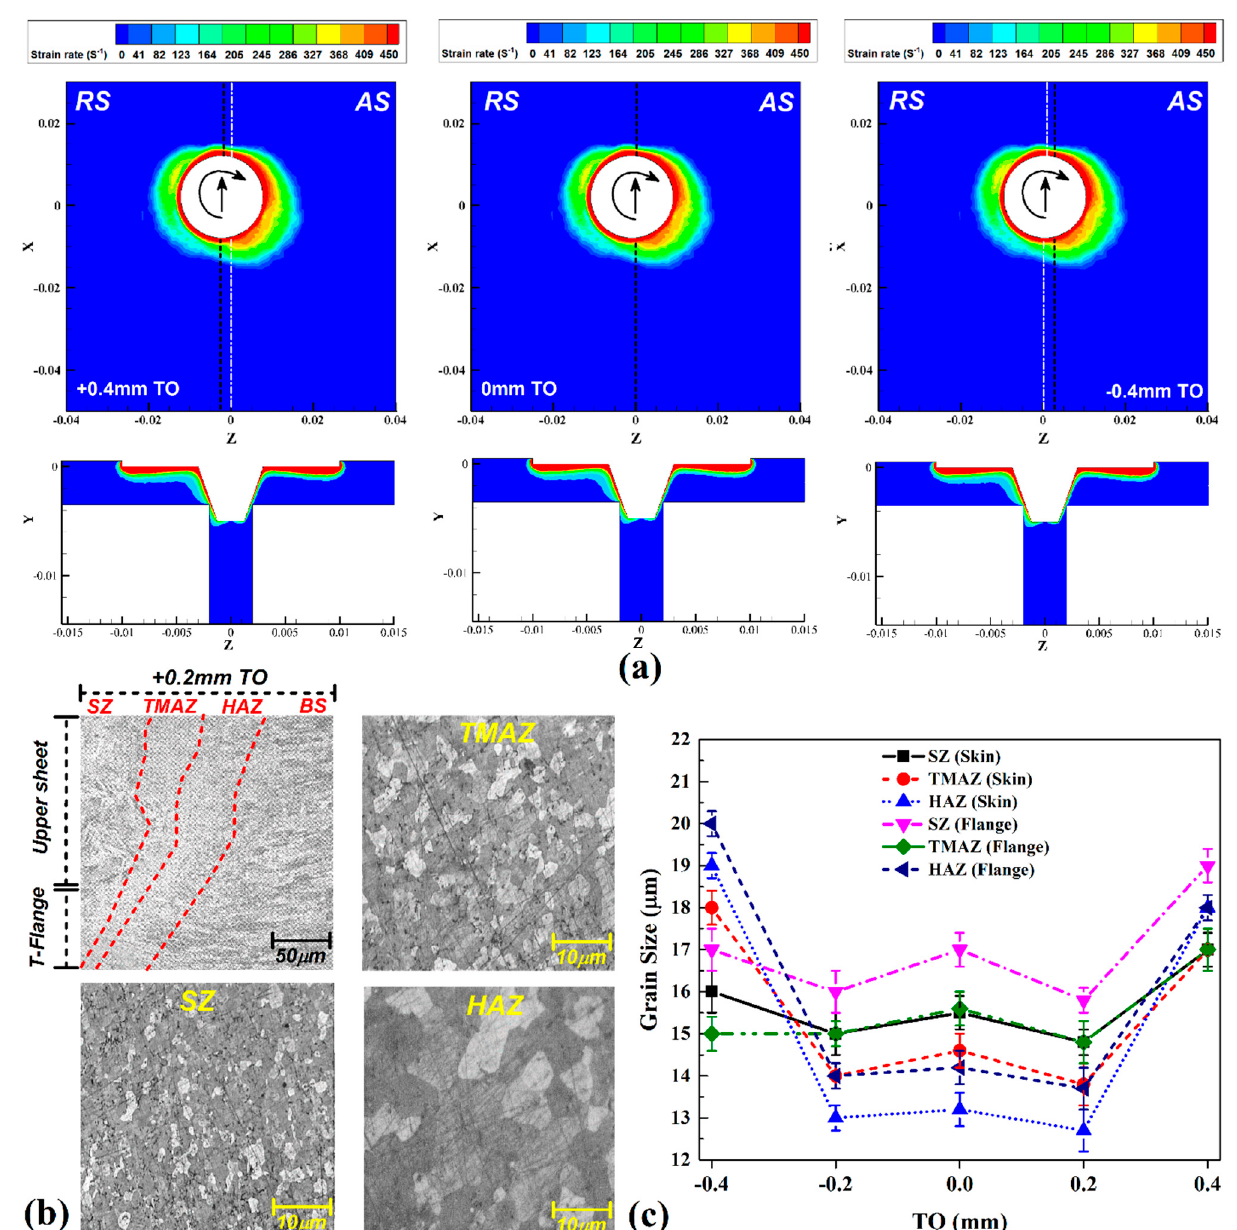
Figure 7. ( a ) Simulation results of Strain rate in various cases. ( b ) Microstructure of SZ in case 2. ( c ) Statistic results of grain size in skin and flange at different cases.